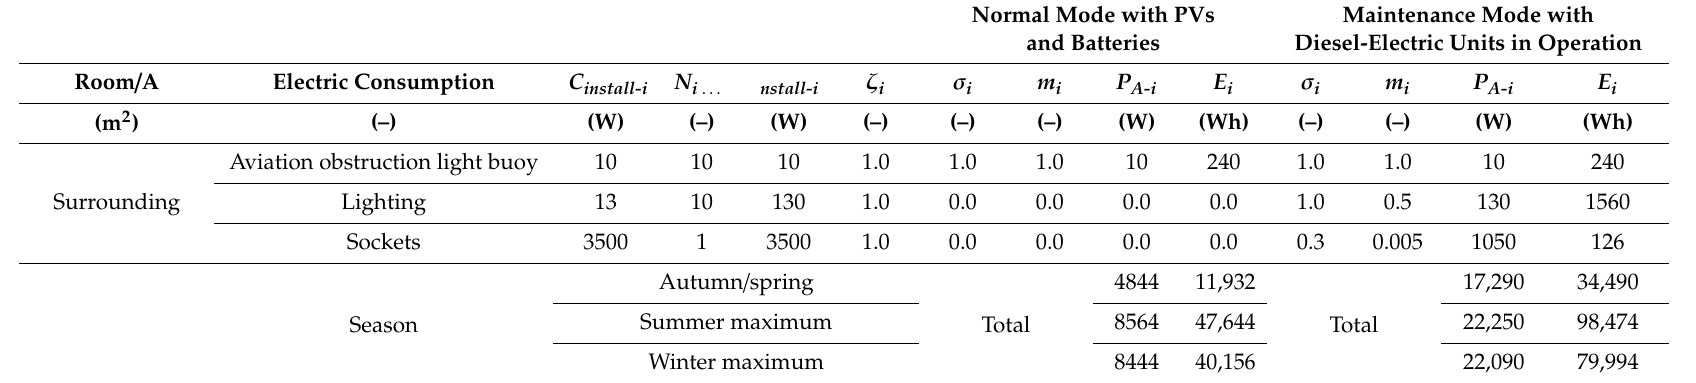
Table 3. Daily peak power and energy consumption for the electrode station in Stachtoroi Island, Attica.